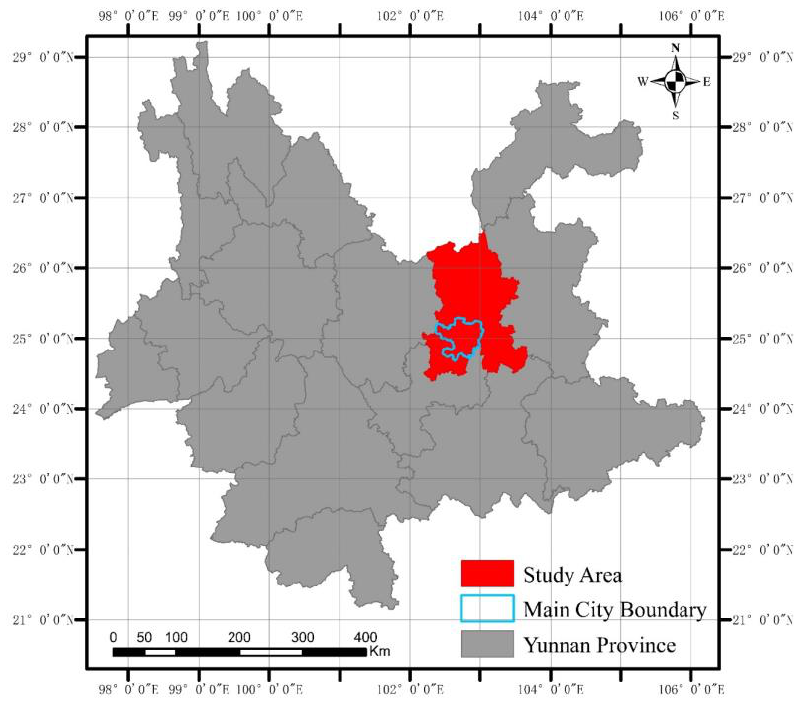
Table 1. Data Declaration.